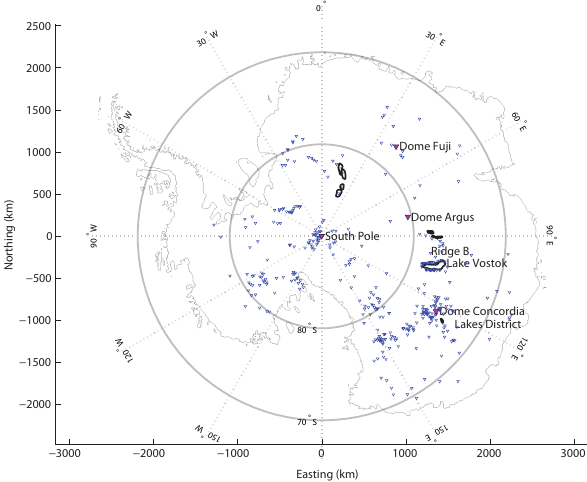
Fig. 1. Map of major drill sites and locations cited in the paper. Blue triangles depict the 379 subglacial lakes (Wright and Siegert, 2012), major lakes are highlighted by black lines.